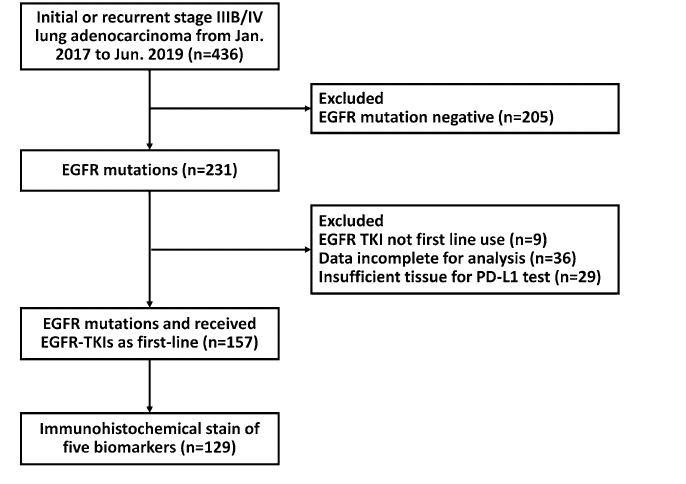
Figure 1. Patient flowchart.